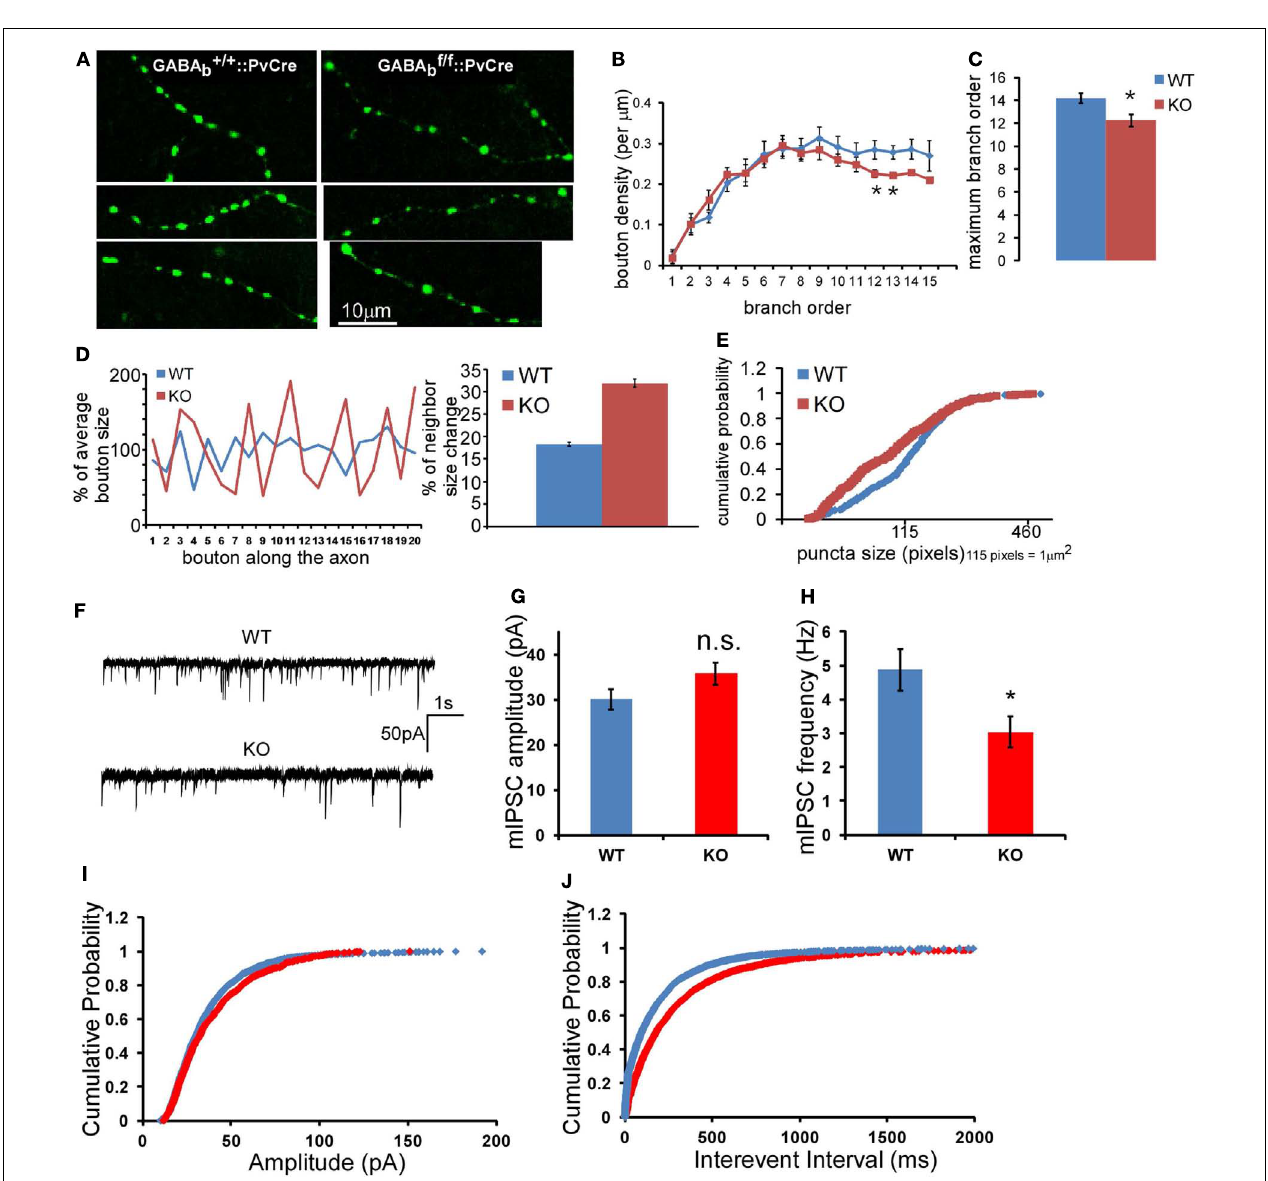
calculated as described in the Section “Materials and Methods” and was plotted. Data were from 11 axons segments of three cells of bothWT and KO neurons, which contained 268 boutons inWT axons and 246 boutons in KO axons (Student t -test, P < 0.0001). (E) Boutons of terminal axon branches of bothWT and KO neurons were quantified, and the cumulative probability of bouton size distribution was plotted (332 boutons forWT, 328 boutons for KO; K-S test, P < 0.0001). (F) Sample traces of mIPSC recorded from layer 2/3 pyramidal neuronsWT and GABA B R KO animals. (G) Average mIPSC amplitude of all recorded neurons. (H) Average mIPSC frequency of all recorded neurons ( n = 15 for each group, P = 0.02, fiveWT mice and five KO mice). (I) The cumulative distribution of mIPSC amplitude. (J) The cumulative distribution of mIPSC inter-event interval ( K-S test, P <